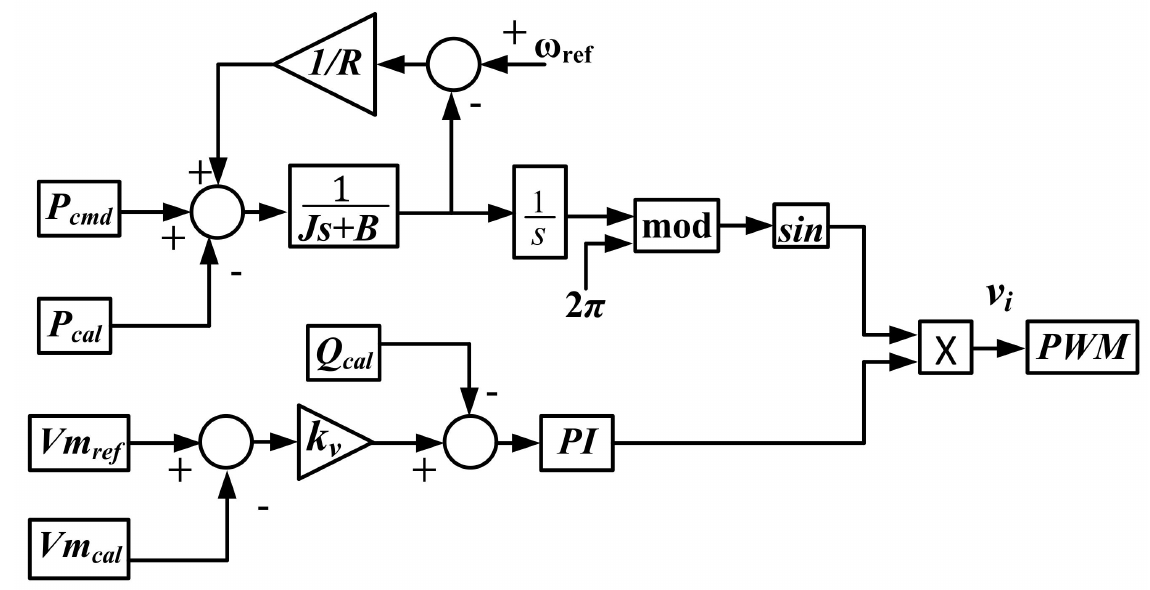
Figure 4. Inverter control loop for voltage and frequency